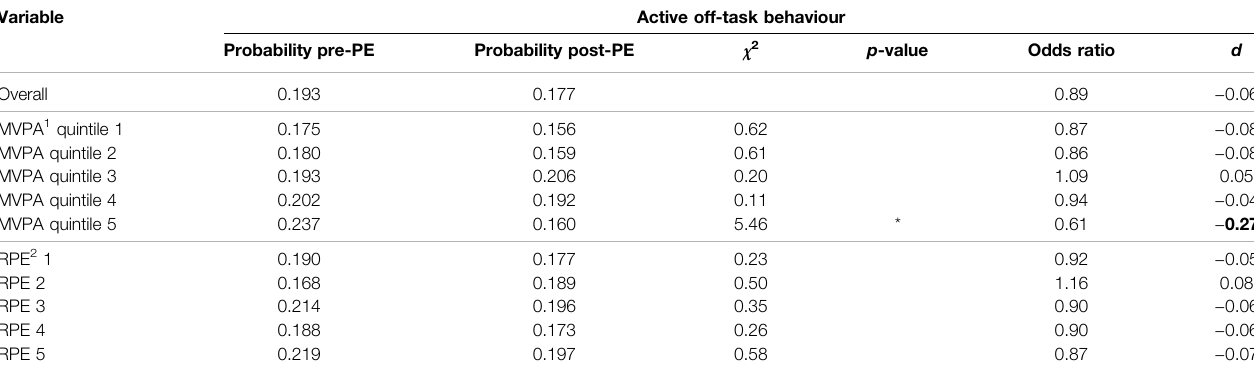
TABLE 3 | Response of active off-task behaviour to objective and subjective PA. Variable Active off-task behaviour Probability pre-PE Probability post-PE χ 2